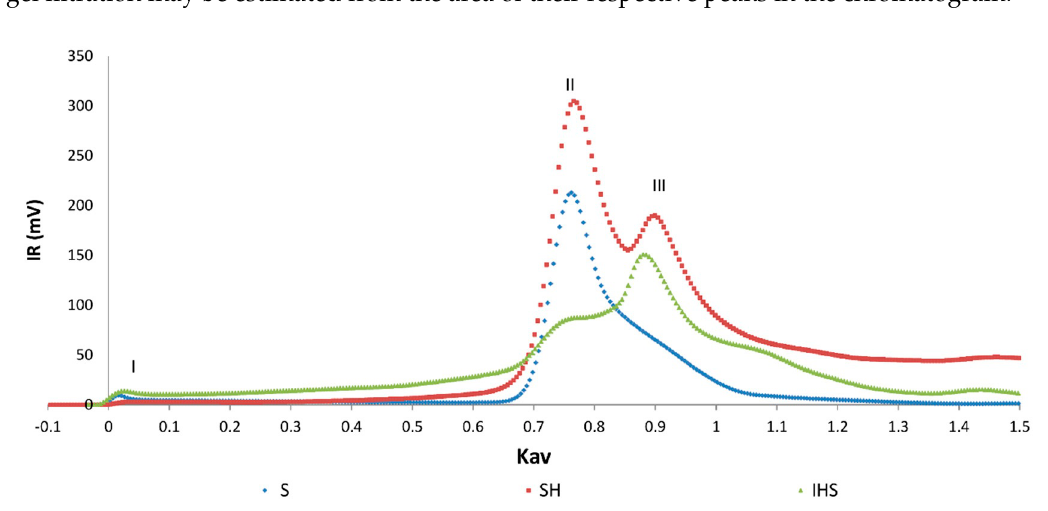
Figure 4. Gel filtration chromatograms on a Biogel P-2 column using IR detection of the soluble fraction of DL (S), its hydrolysis products (SH), and the hydrolysis products of the insoluble fraction (IHS). Kav: Analyte partition coefficient.